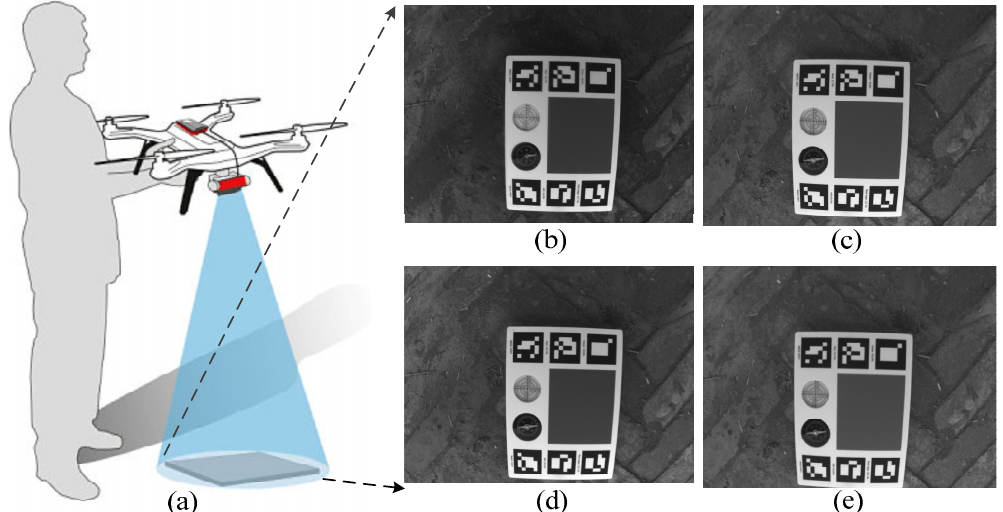
Figure 3. Sketch of radiometric calibration ( a ) and captured green ( b ), red ( c ), red-edge ( d ), and NIR ( e ) band images for radiometric calibration in the study area.